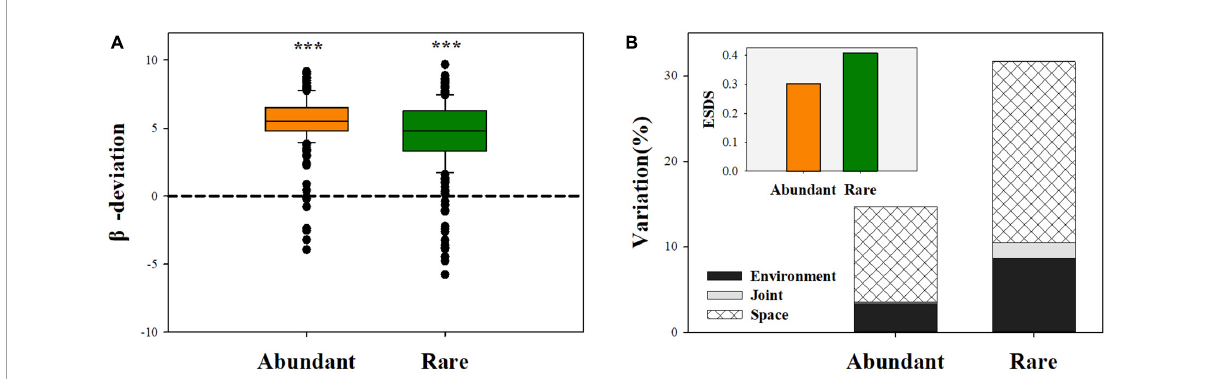
FIGURE4 The β -deviations for abundant and rare fungal subcommunities. (A) Difference between abundant and rare fungal β -deviation and 0 values; (B) variation in β -deviations were explained by spatial and environmental variables after forward-model selection. *** P < 0.0001; Wilcoxon rank-sum test.